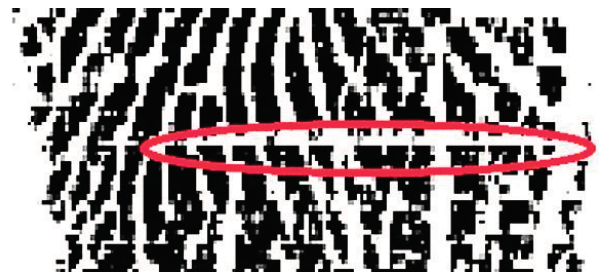
Figure 5. A pseudo truncated fingerprint caused by horizontal